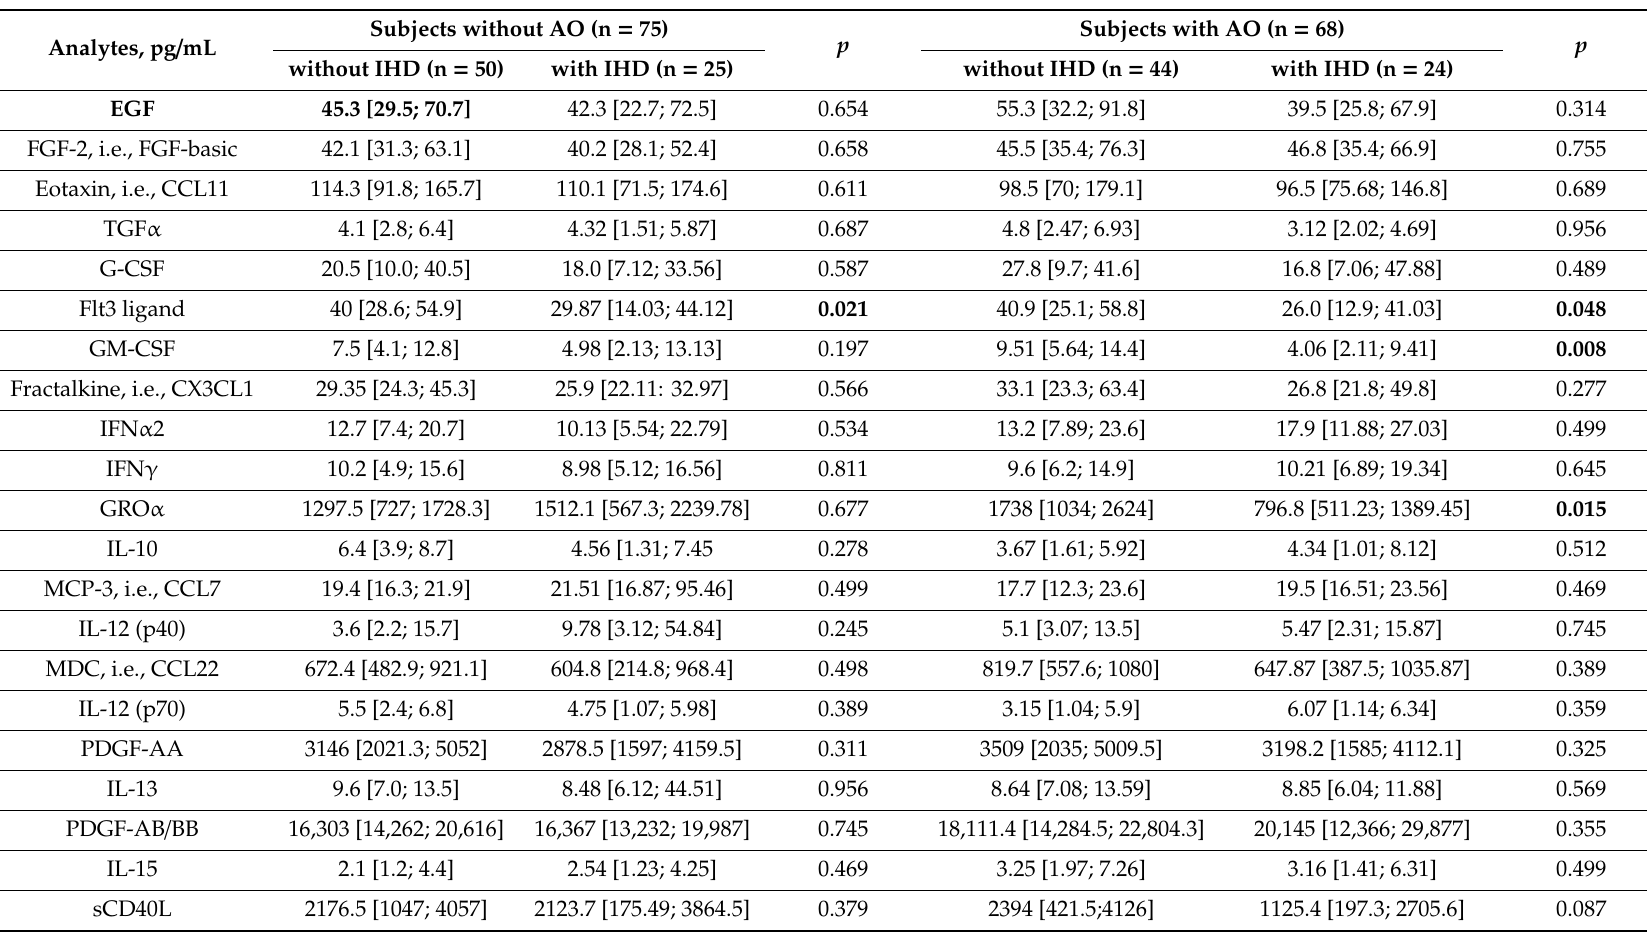
Table 3. Levels of the analyzed human cytokines / chemokines in IHD comorbid with AO and without AO (median (lower; upper